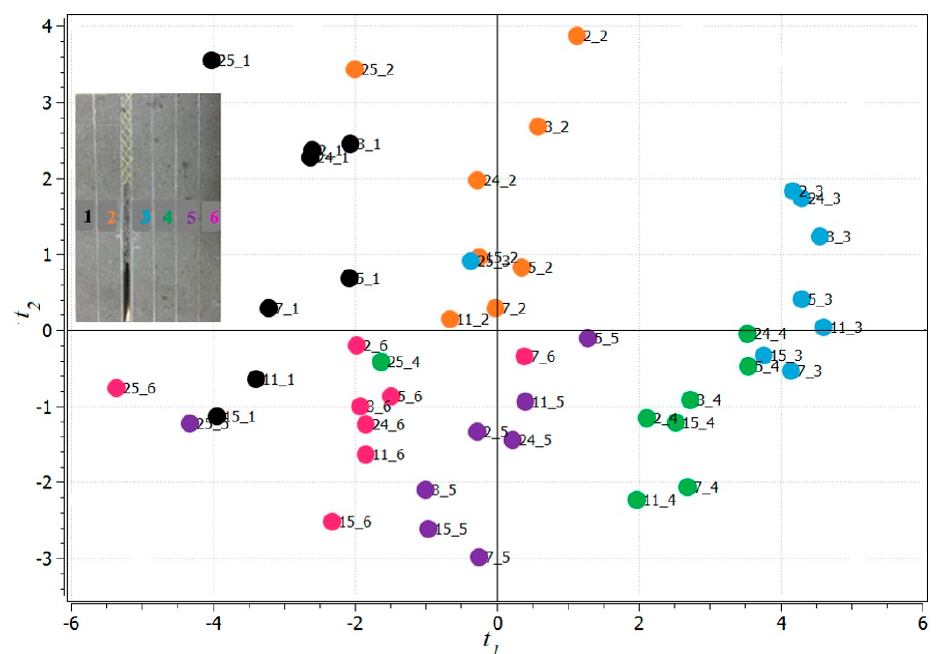
Figure 5. Score plot of the PCA model ( t 1 – t 2 ) showing the clustering pattern of the corridors in each slice based on their textural features extracted from X-ray images. Observations are identified by the slice number (red numbers in Figure 1) followed by the corridor number (1–6). Different colors are used to distinguish the corridors as shown in the anode slice image included in the figure.